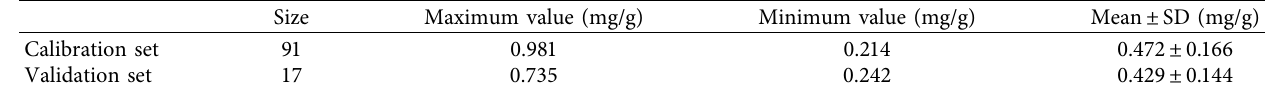
Figure 3: Scatter plot of pachymic acid content in Poria samples. Table 2: Pachymic acid content range in Poria samples from the calibration set and validation set.